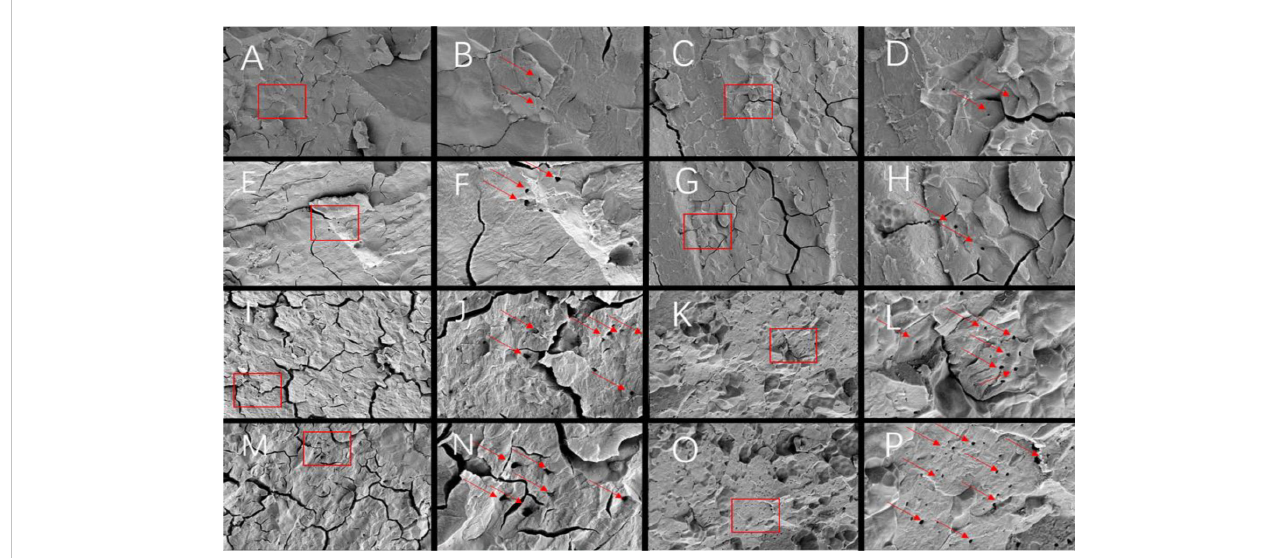
FIGURE 3 Endosperm back of (A, B) normal grains and (C, D) non-chalky grains of Y28, (E, F) normal grains and (G, H) non-chalky grains of N5718, (I, J) normal grains and (K, L) non-chalky grains of W113, (M, N) normal grains and (O, P) non-chalky grains of Y5118. Images A/C/E/G/I/K/M/O are at 1500x and Images B/D/F/H/J/L/N/P are at 5000x. Images B/D/F/H/J/L/N/P are the enlarged view of red rectangle areas in A/C/E/G/I/K/M/O, respectively.